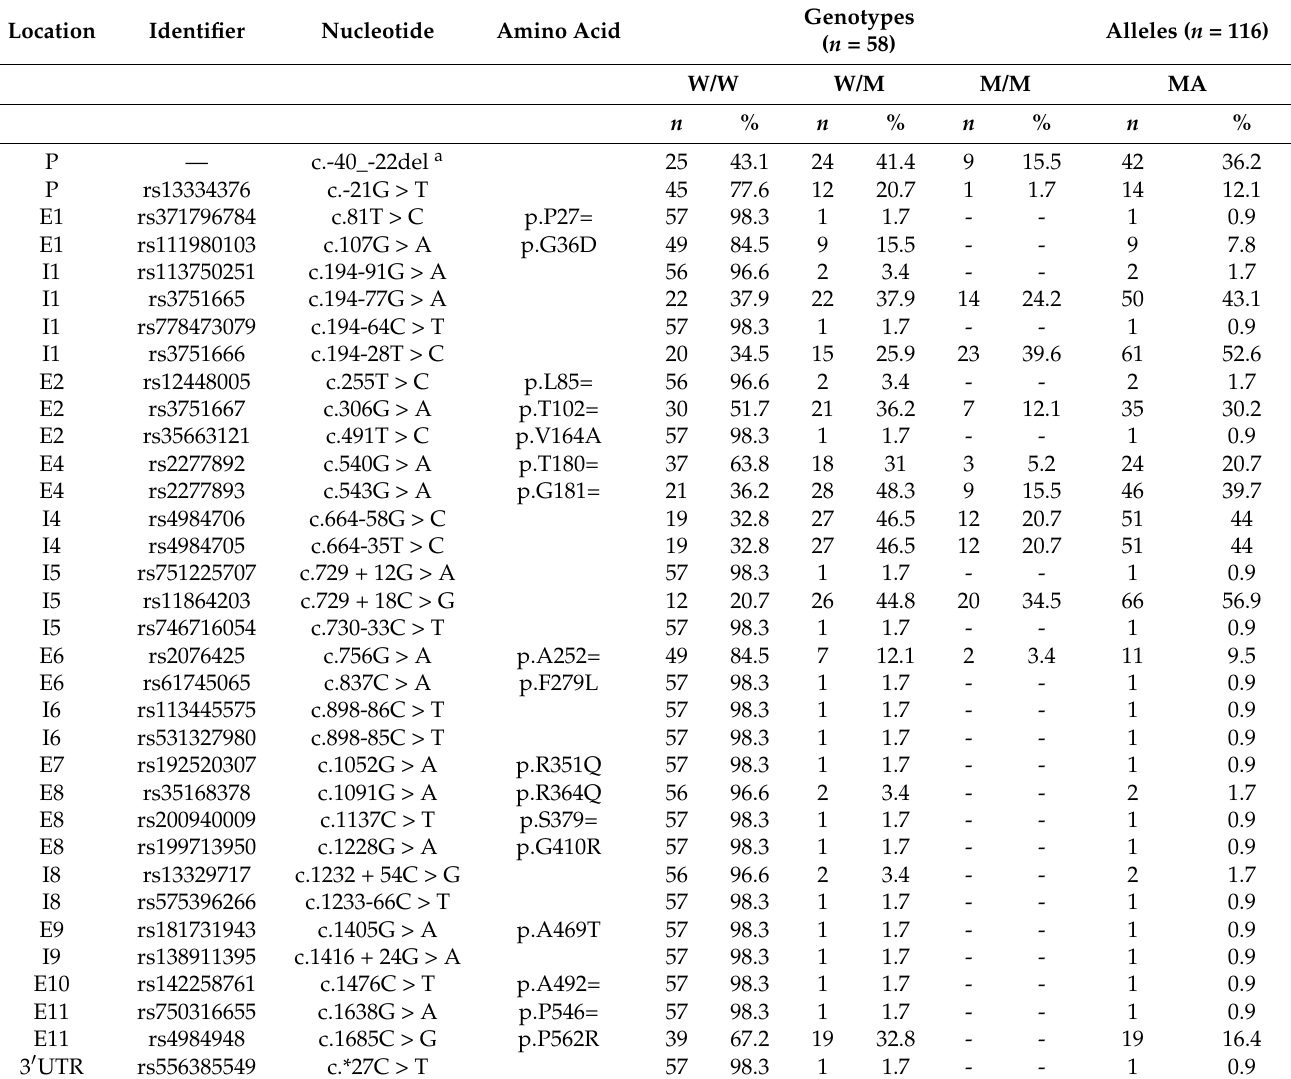
Table 3. Genotypic and allelic frequencies of variants in the LMF1 gene detected in patients with primary